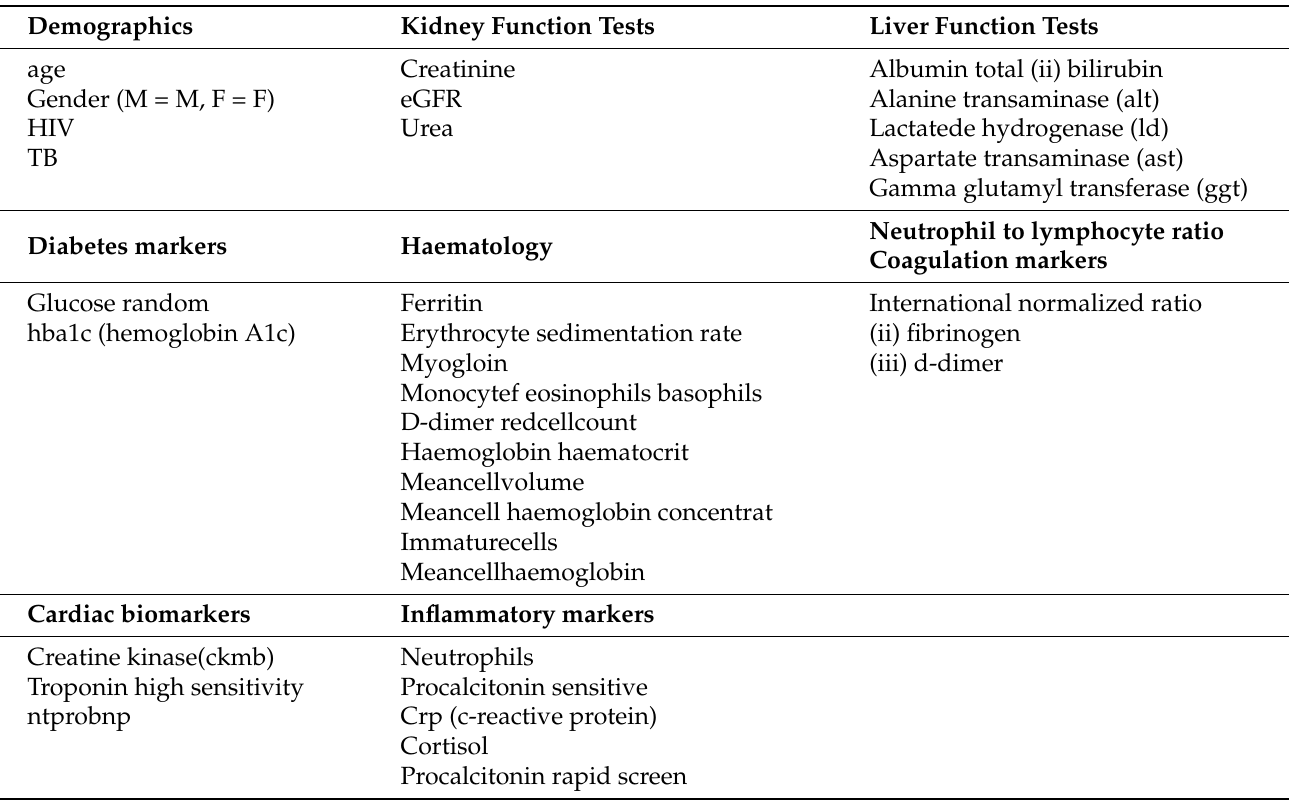
Table 4. List of variables